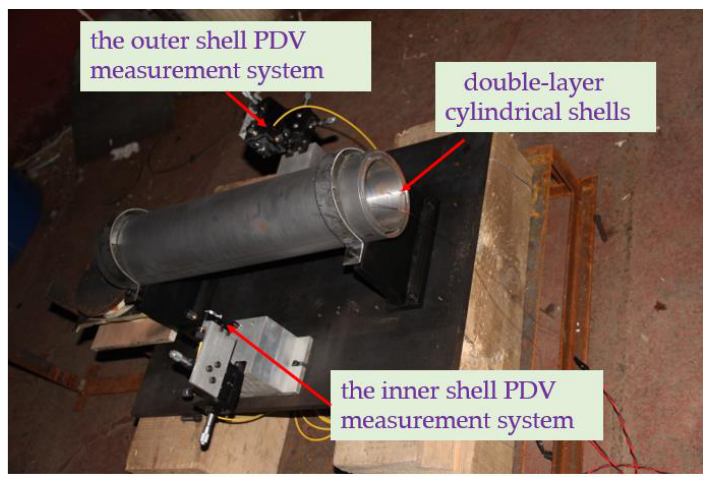
Figure 4. Experimental device of PDV measurement double-layer cylindrical shells.